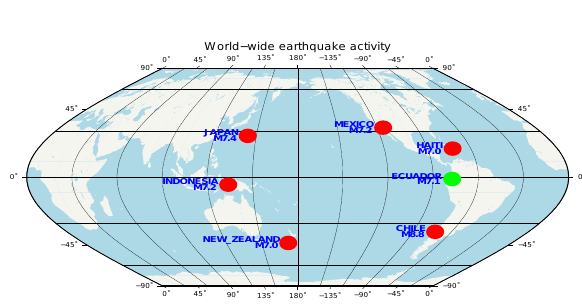
normal distribution with median µ and standard deviation σ . We have done a statistical analysis for a large amount of TEC, and referred to other scholars’ literature. We think it is suitable to choose 1.5 σ (confidence level 86.64 %) as the boundary of anomaly determination (i.e. the variation in the TEC should be less than µ ± 1.5 σ) . If the TEC value was larger than µ +1.5 σ , it was defined as a positive anomaly; and if the TEC value was smaller than µ − 1.5 σ , it was de- fined as a negative anomaly. Each day (0–14 days) before an earthquake was checked by the “sliding window” method described